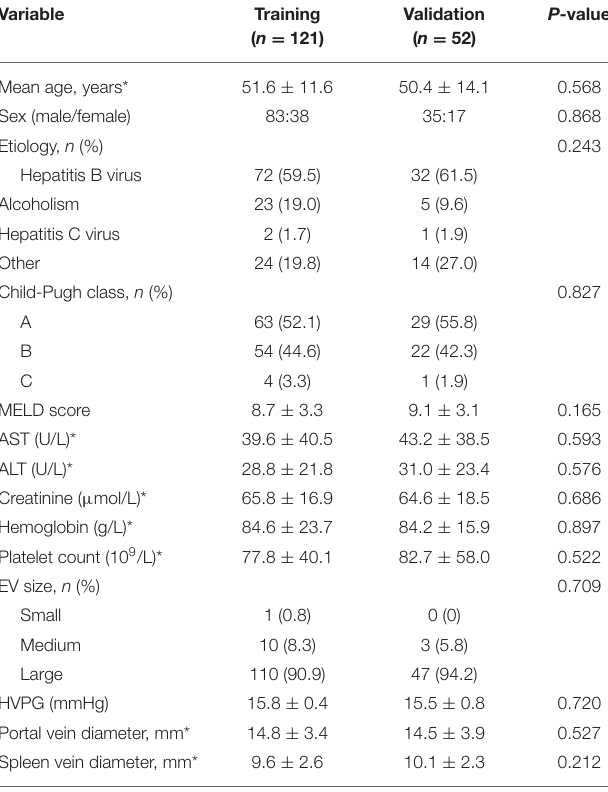
TABLE 1 | Clinical characteristics of patients in the training and validation cohorts.